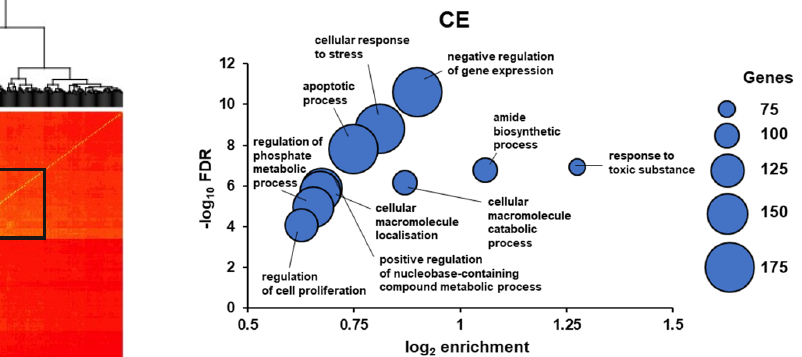
Figure 7. ( A ) Hypernetwork analysis of day 6 TE-interacting endometrial ciliated epithelial genes